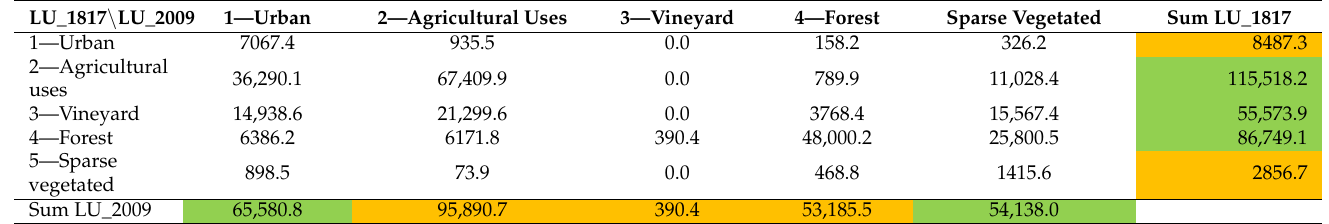
Table 5. Contingency table of land cover change for the period 1817–2009. Results represent the areas under change and are expressed in ha. Cells in orange report a loss in ha, while green ones report a net gain in ha.